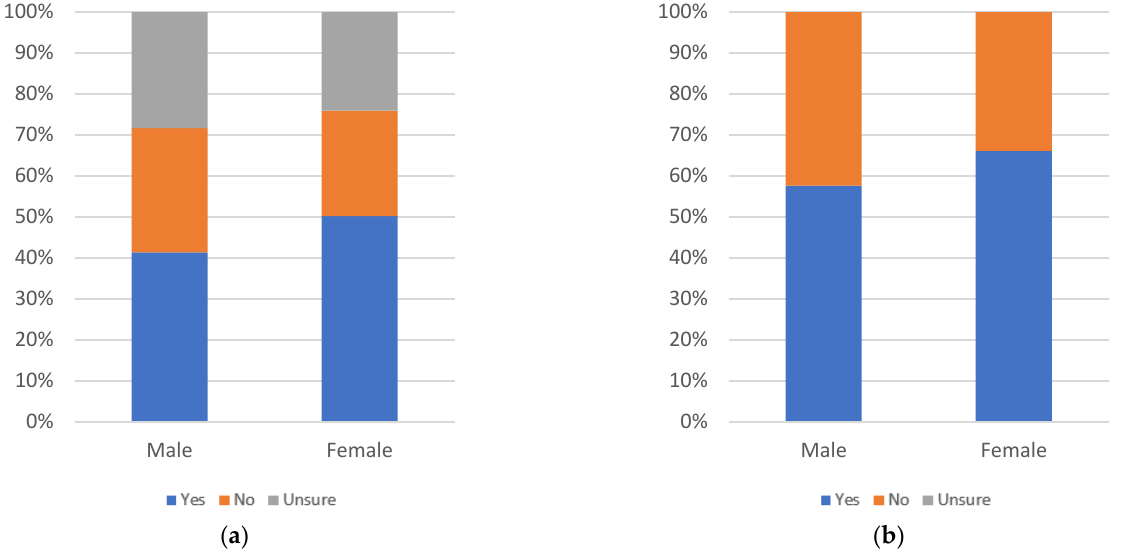
Figure 112. Label others’ use, by gender: ( a ) with uncertain respondents (left) and ( b ) without uncertain respondents (right).